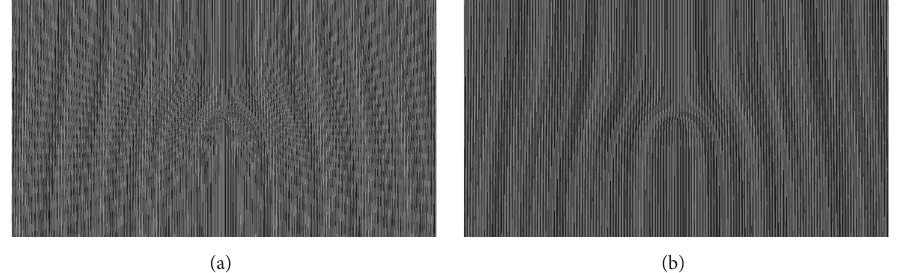
Figure 1: The phase structure of the Dammann vortex grating, (a) the original DVG and (b) the EDVG.